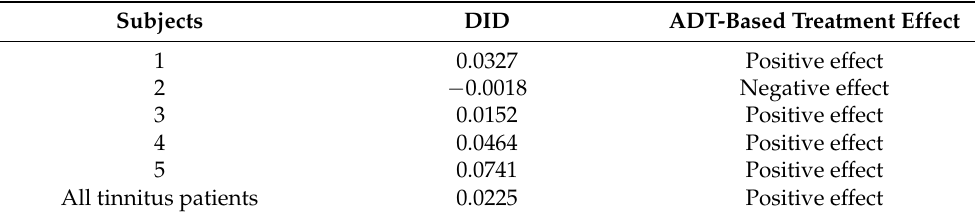
Table 7. DID between-subjects and within-subjects.